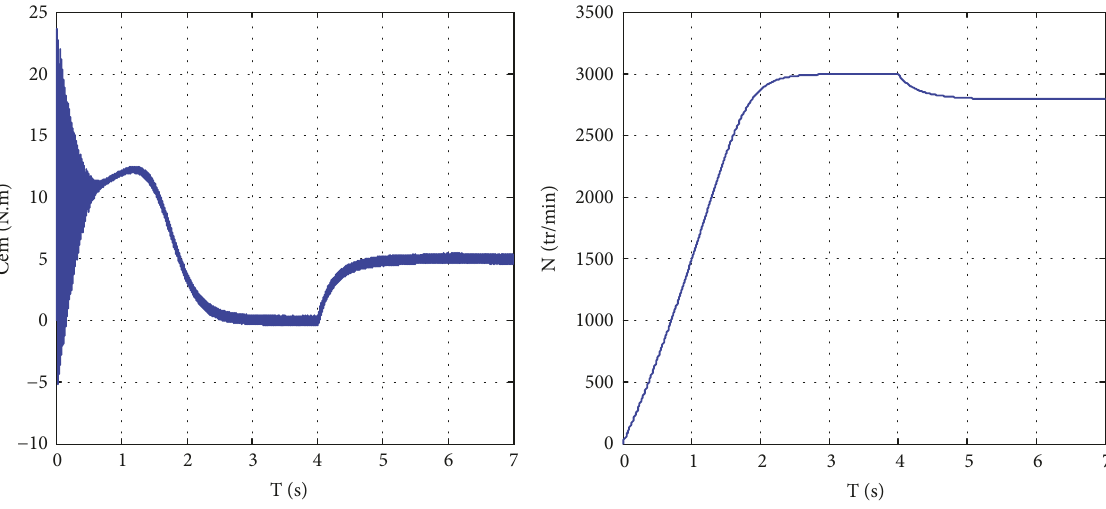
Figure 9: Electromagnetic torque and rotational speed for m =